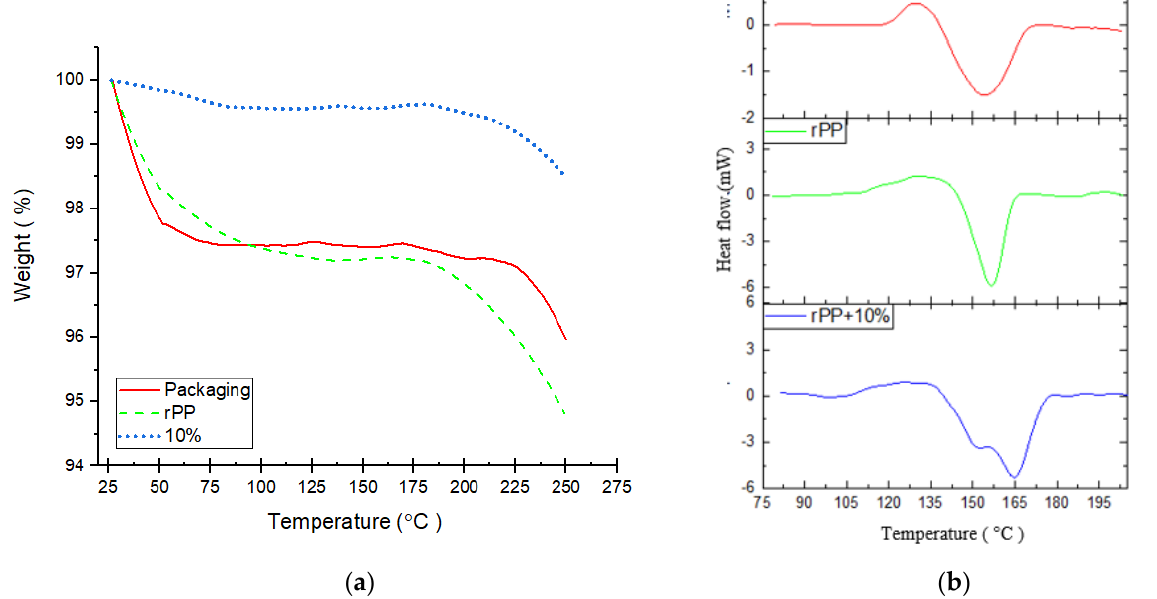
Figure 7. Thermal characterization of packaging plastic, rPP and rPP + 10%. ( a ) TGA; ( b ) DSC.